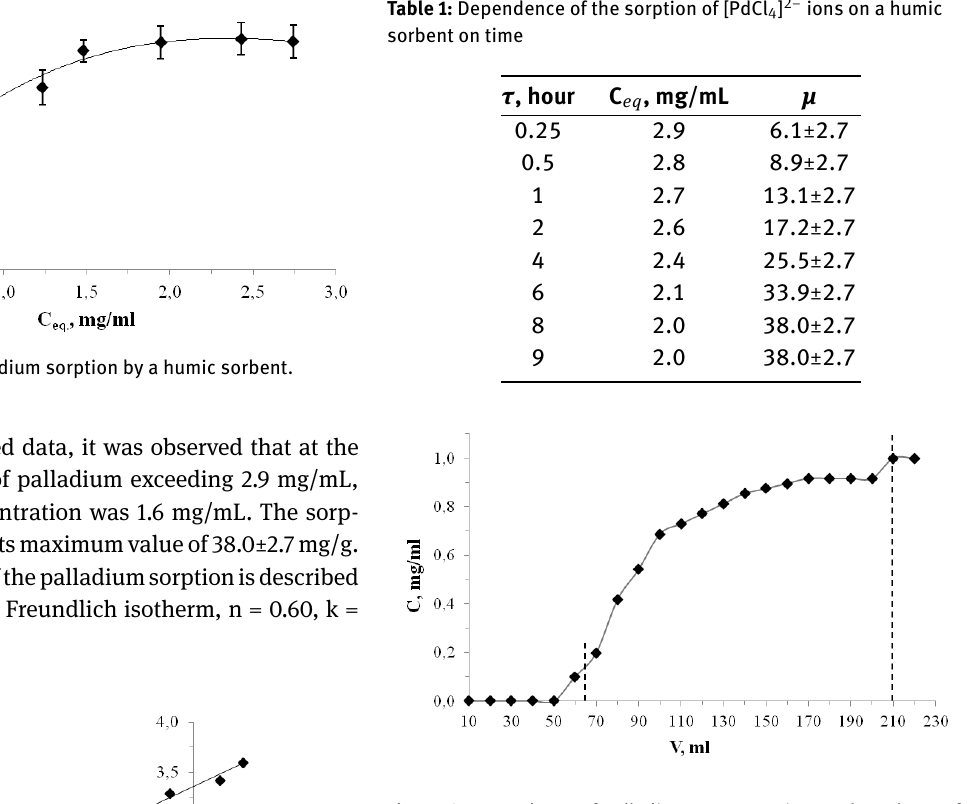
Figure 6: Dependence of palladium concentration on the volume of the solution passed through the humic sorbent.